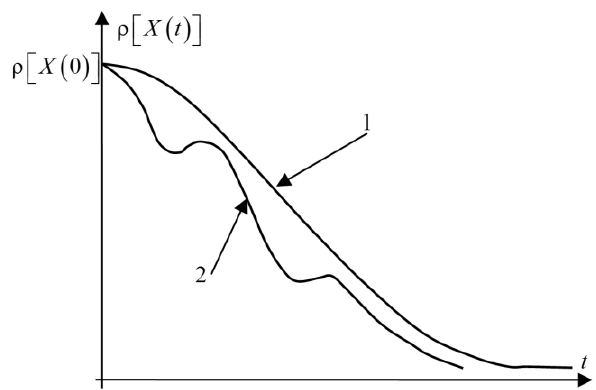
Figure 5. Norm of the vector of state X ( t ) ρ[ X ( t )]: 1 – solution of the tasks of parametric synthesis; 2 – at several local minimums (8) If functional (8) had several local minimums, then such minimums would be affected by the trajectory of the curve ρ[ X ( t )] (Fig. 5, curve 2). Thus, functional (8) calculated on the solutions of the dynamic system (32)